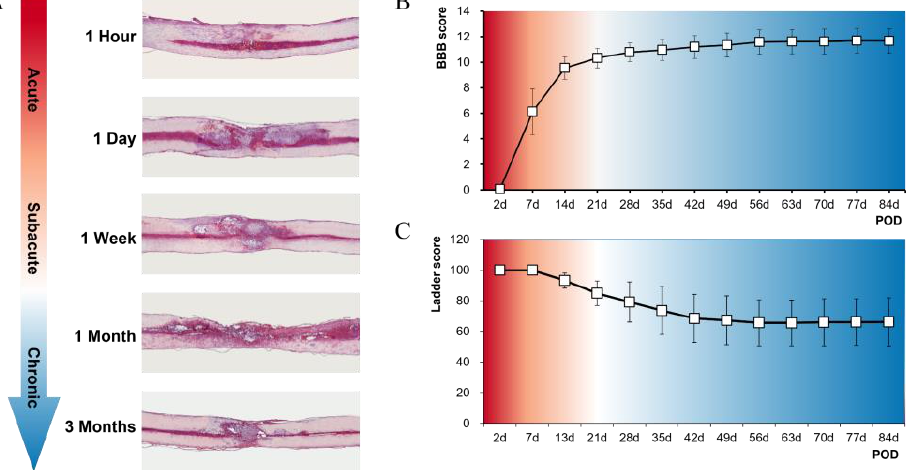
Figure 1. Histological and functional results of a spinal cord contusion model in rats. ( A ) representative images of hematoxylin and eosin staining at five time points from 1 hour to 3 months; ( B , C ) locomotor functions following SCI. Basso – Beattie – Bresnahan (BBB) scores ( B ) and ladder scores ( C ) over a 3-month period SCI model ( n = 9) from 2 to 84 days after operation. Abbreviation: POD = postoperative days.